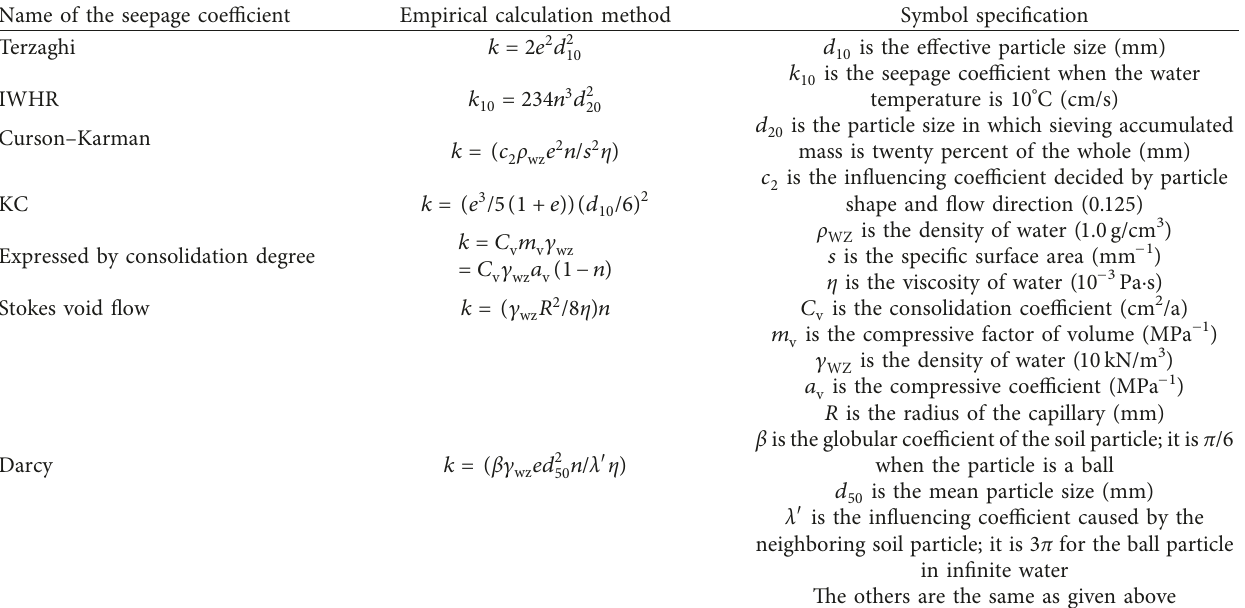
Table 4: Existing empirical calculation methods of the seepage coefficient for coarse-grained